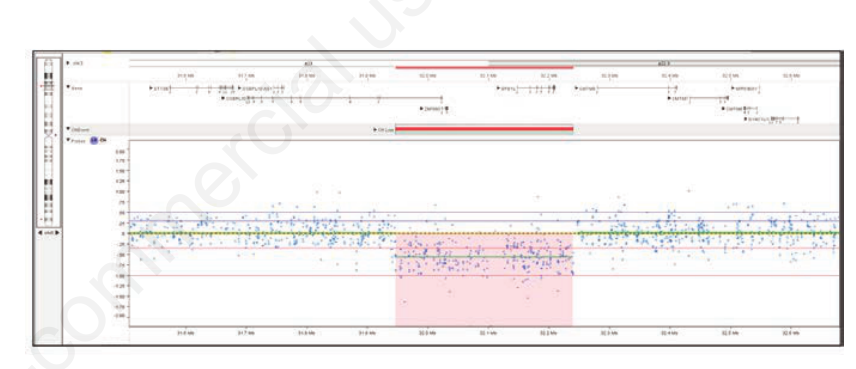
Figure 1. Schematic result of the single nucleotide polymorphism array results.